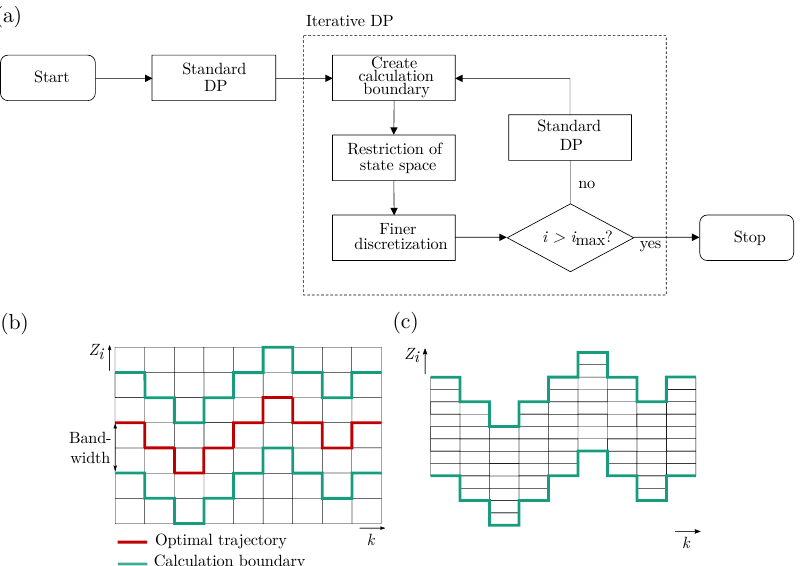
Figure 3. Program structure of the iDP approach ( a ), schematic representation of pre-loop with discrete bandwidth of 2 ( b ), and discretization of the first iteration loop ( c